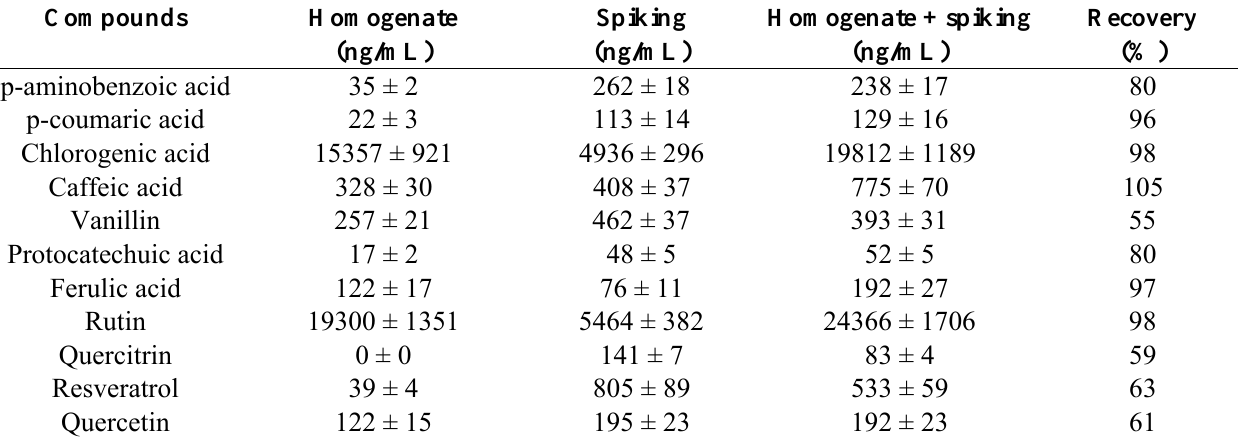
Table 8. Maceration 50 °C.